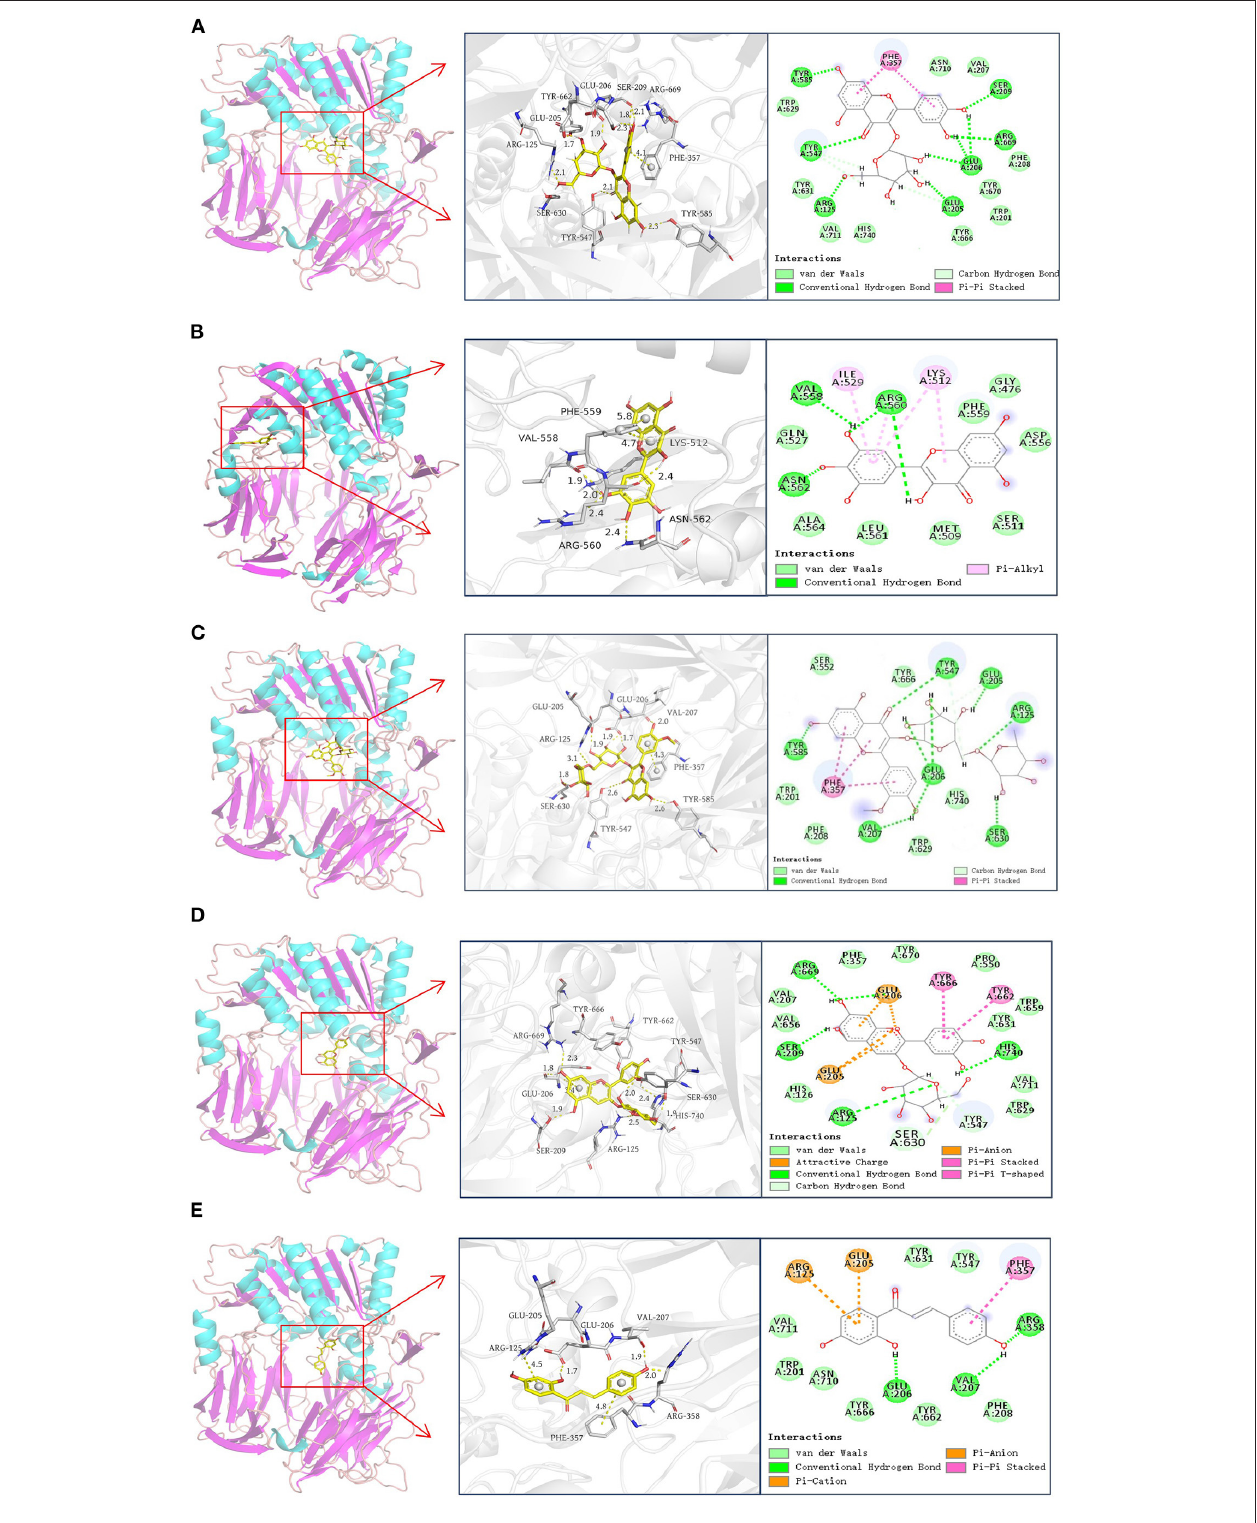
FIGURE 6 | Docking results of hyperoside (A) , myricetin (B) , narcissoside (C) , cyanidin 3-O-glucoside (D) , isoliquiritigenin (E) with DPP-4.